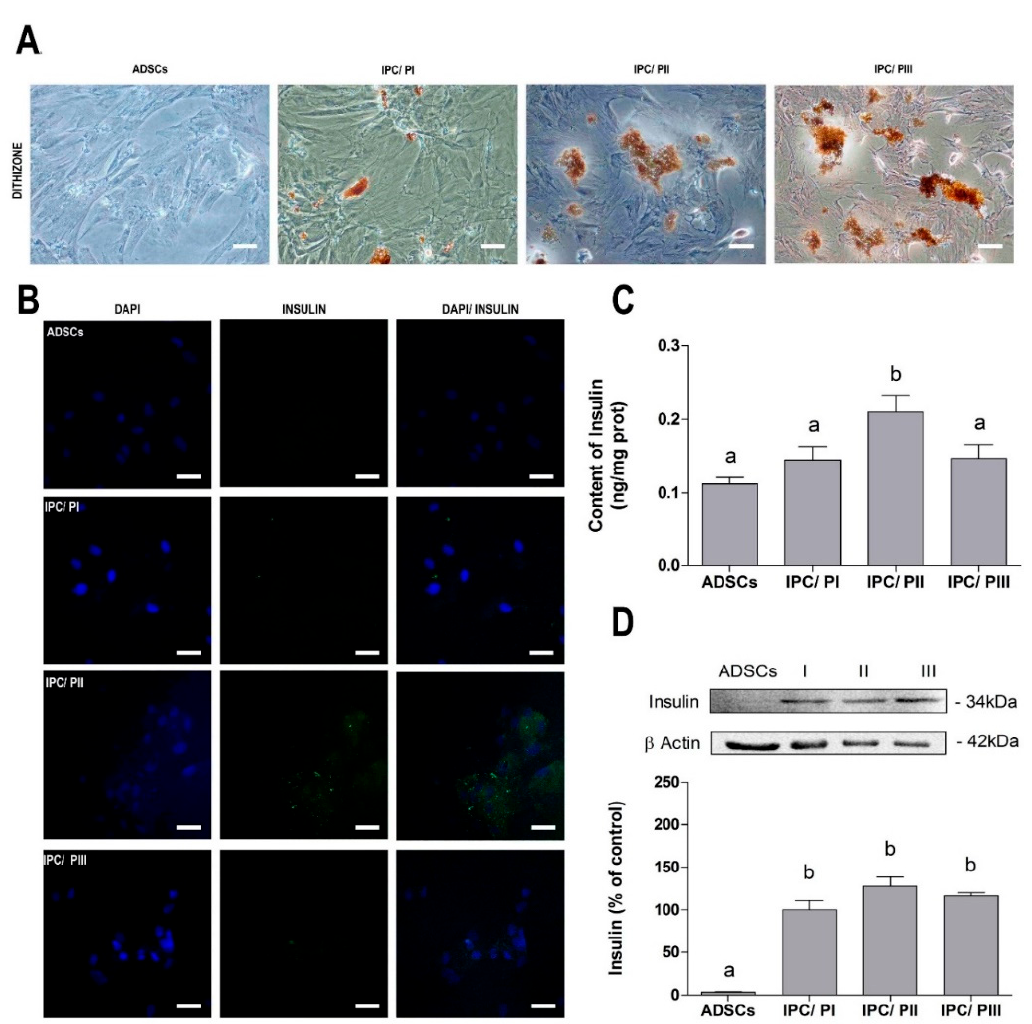
Figure 2. Di ff erentiation of ADSCs into insulin-producing cells (IPCs). ( A ) Dithizone (DTZ) staining for indirect insulin assessment at 20 × magnification by phase-contrast microscopy. Scale bar = 60 µ M; ( B ) immunofluorescence for insulin (green) and DAPI nuclear staining (blue), at 40 × magnification by confocal microscopy. Scale bar = 30 µ M; ( C ) insulin content, measured by ELISA; and ( D ) pro-insulin content, evaluated by Western blotting. Data are expressed as means ± SE of 6 independent experiments performed in triplicate. Letters indicate di ff erent statistical groups by ANOVA followed by Tukey’s test, assuming p < 0.05.